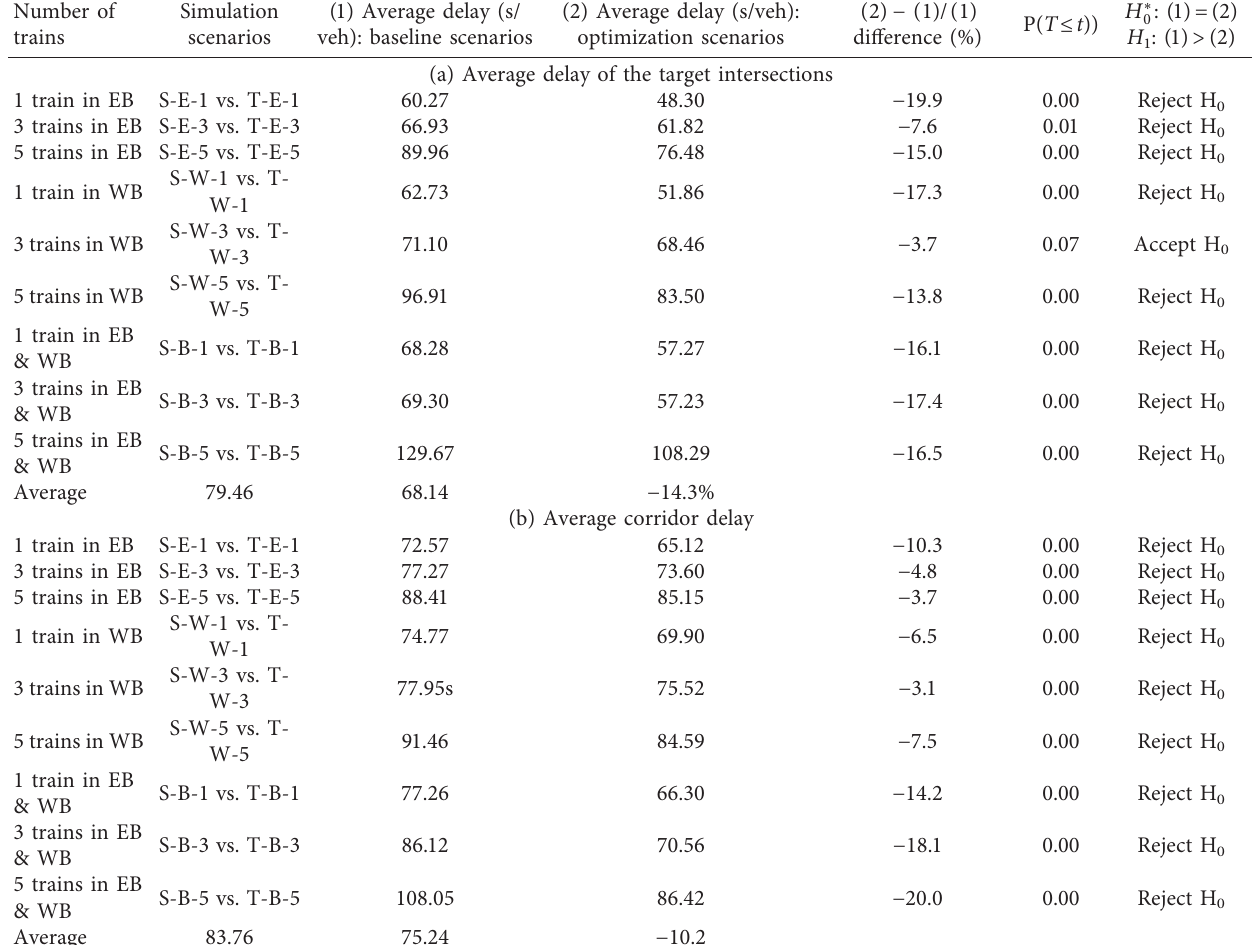
Table 7: Comparison of multiple run results between optimization and baseline